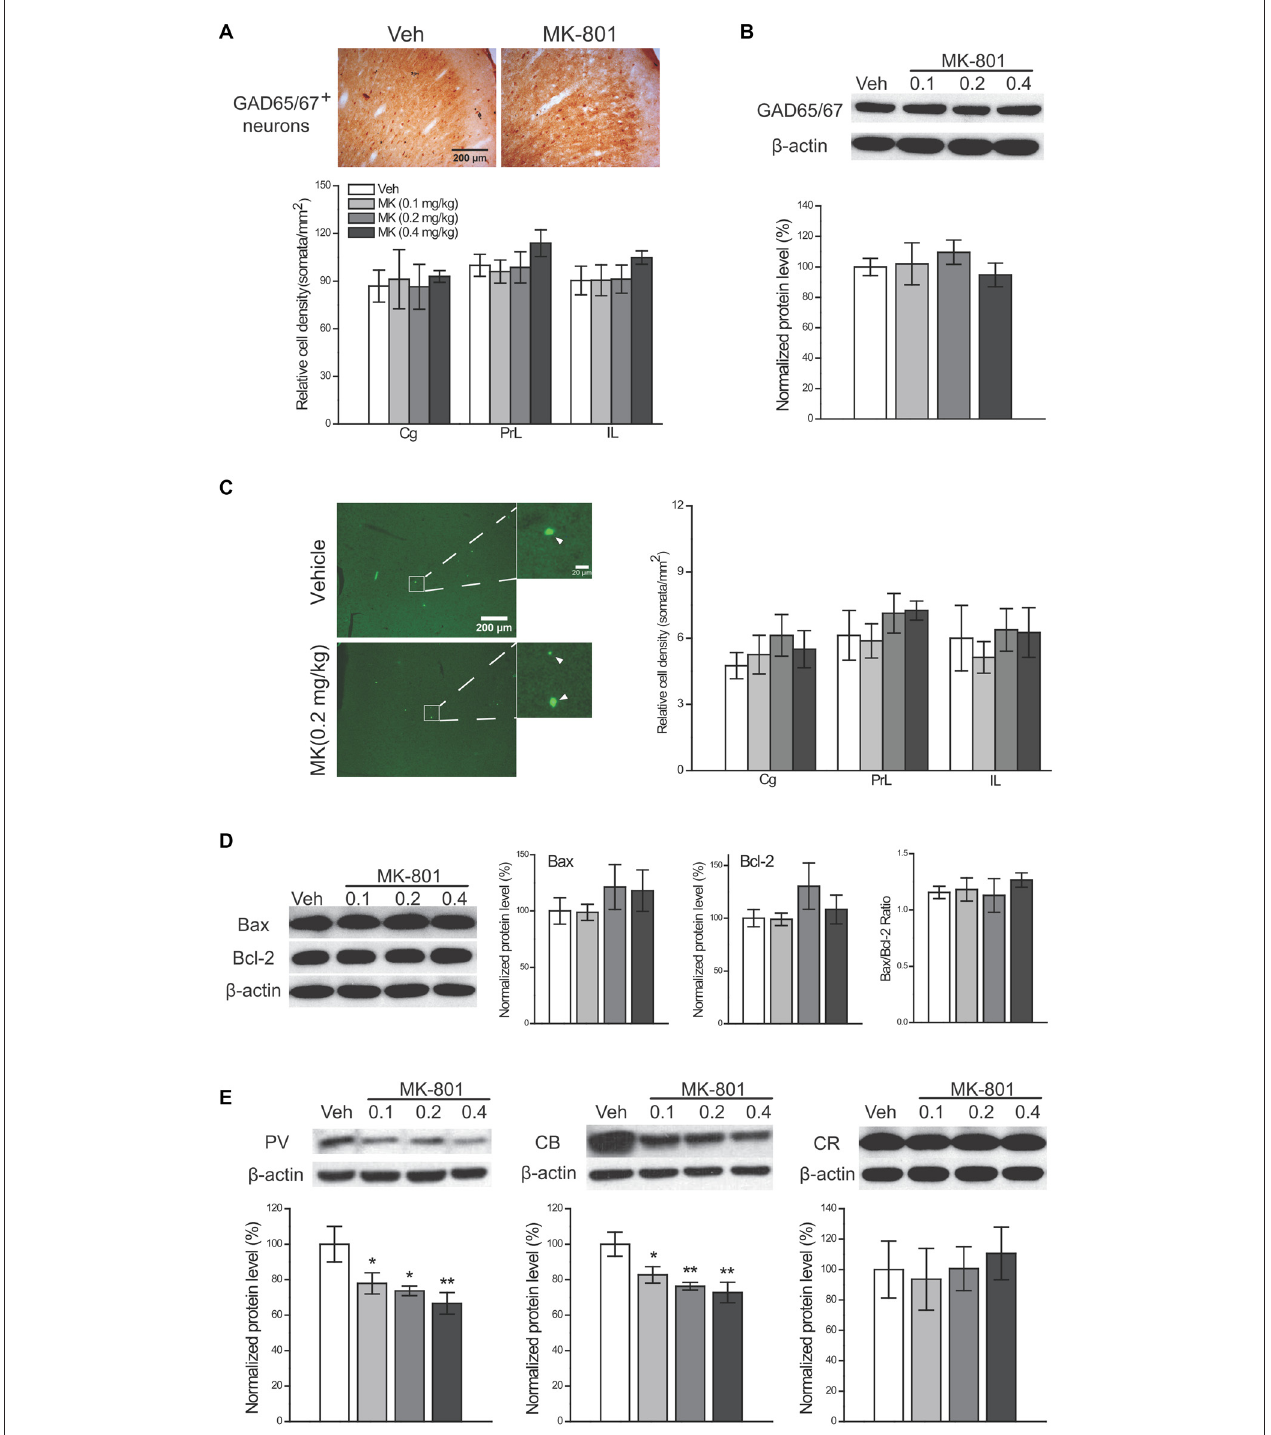
FIGURE 6 | Investigation of the mechanisms of MK-801-induced reductions in GABAergic interneurons. Effects of subchronic treatment of MK-801 (0.1, 0.2, 0.4 mg/kg, once daily) during adolescence (PND 29–42) on the density of GAD65/67 + neurons (A) and the protein levels of GAD65/67 (B) the density of apoptotic cells (C) the expression levels of two apoptosis-related molecules (Bax and Bcl-2) and their ratio (D) and expression levels of three CBPs. (E) Representative sections show GAD65/67-immunoreactive neurons (A) and apoptotic cells ( C , arrowhead-labeled), respectively, in the cingulate subregion in animals receiving either vehicle or MK-801 (0.2 mg/kg) treatment. n = 4 per group for cell counts and n = 5 per group for other results. ∗ p < 0.05, ∗∗ p < 0.01 compared with the vehicle group. Cg, cingulate cortex; PrL, prelimbic cortex; IL, infralimbic cortex.